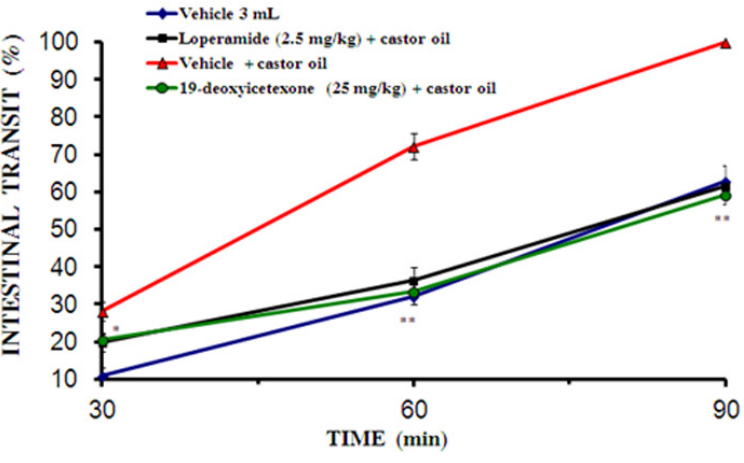
Figure 3. Effects of 19-deoxyicetexone (25 mg/kg) on intestinal transit in rats. The results are the means of five determinations ± standard error. * p < 0.05 with respect to the castor oil-treated group.